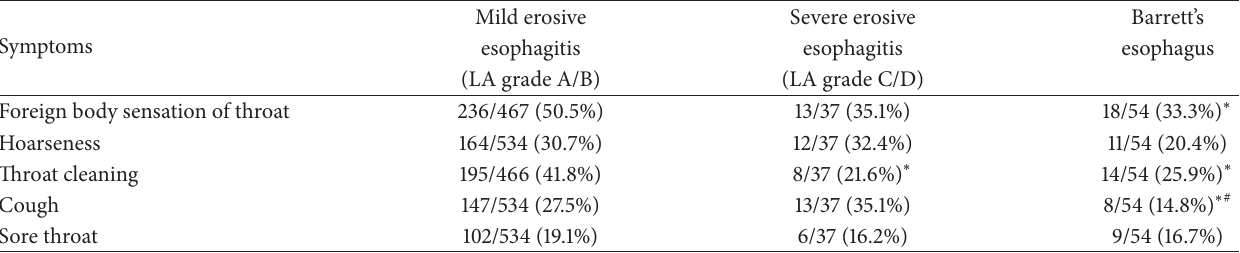
Table 3: Frequencies of extragastroesophageal symptoms in patients with mild erosive esophagitis, severe erosive esophagitis, and Barrett’s esophagus.